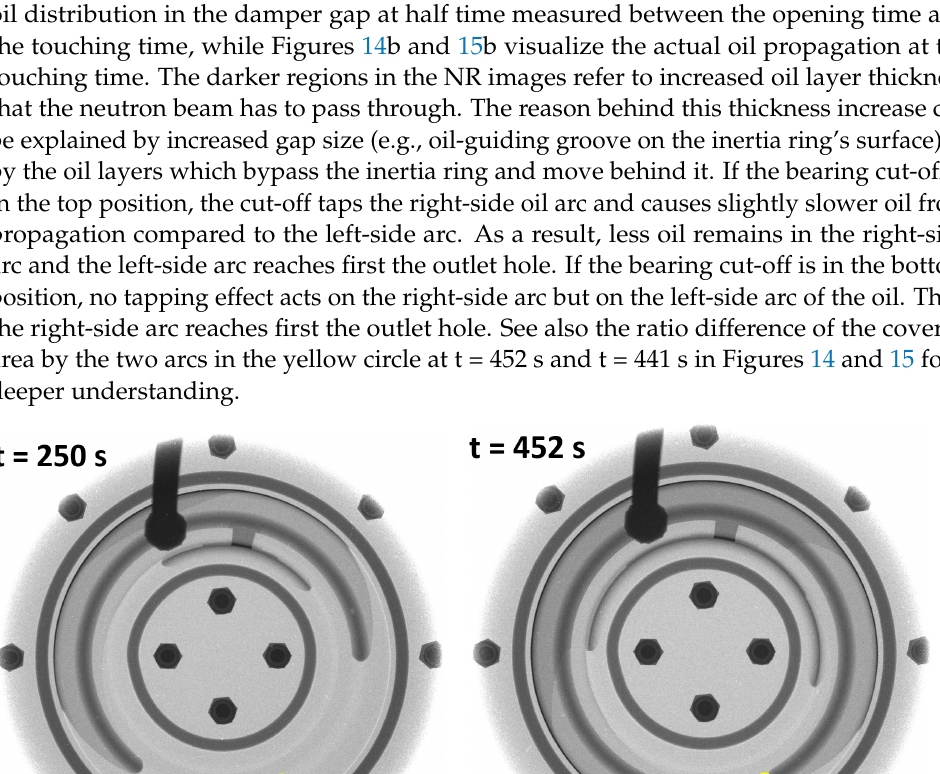
( b ) Figure 15. NR images of the fi lling process for the “Bo tt om” case. ( a ) NR image at half time of the fi lling process; ( b ) NR image at touching time of the fi lling process. 3.2. Numerical Calculation Results The spatial distribution of the silicone oil phase was rendered for two notable moments. Figures 16a and 17a show the actual oil spread at half-time of the propagation while Figures 16b and 17b show the oil distribution at the touching time. One can also calculate the propagation time (measured between the opening time and the touching time) for the “Top” case: 442 s − 47 s = 395 s and for the “Bo tt om” case: 427 s − 47 s = 380 s. The darker regions on the CFD images, similar to NR images, are caused by oil layers that bypass the inertia ring and move behind it. The tapping e ff ect of bearing cut-o ff appears in the CFD results as well: in the “Top” case the left-side oil arc reaches the outlet hole fi rst (see Figure 16b), while in the “Bo tt om” case the right-side oil arc reaches the outlet